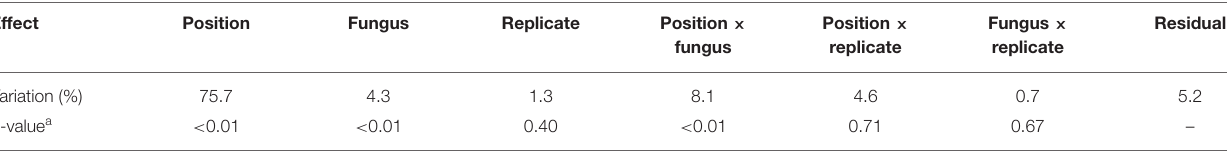
TABLE 1 | The variation and significance of the main effects and their two-factor interactions from ASCA. Effect Position Fungus Replicate Position